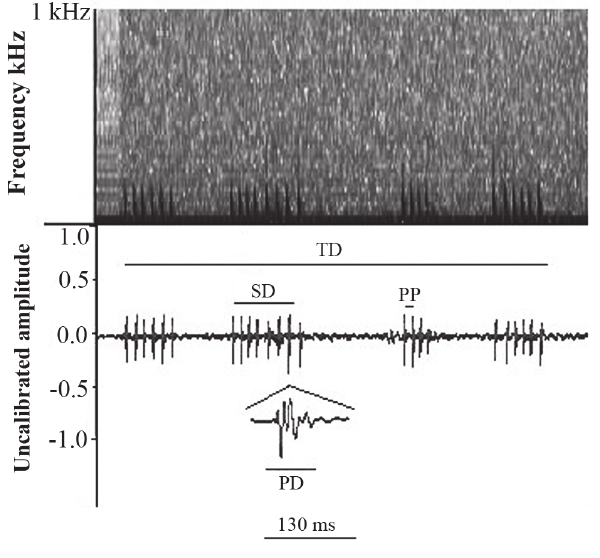
Fig. 3. Sonogram (top) and oscillogram (below) swimbladder drumming sounds recorded underwater illustrating sound characteristics measured. TD = train durations; SD = sound duration; PP = pulse period; PD = pulse durations.